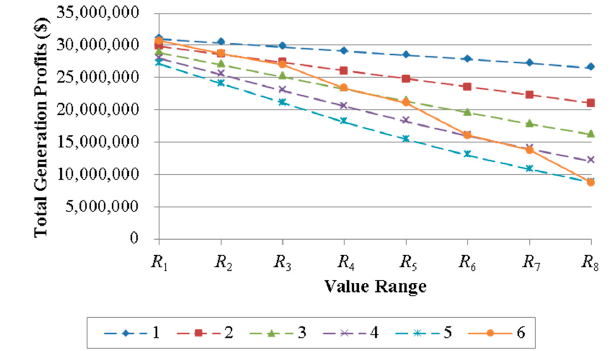
Figure 5. Variations of tax-rate value, emission intensity, and total generation profits with the increase of emission coefficients. Curves 1, 2, 3, 4, and 5 depict the results corresponding to the carbon-tax policy with constant tax rate w 1 , w 2 , w 3 , w 4 , and w 5 , respectively; Curve 6 depicts the results corresponding to the proposed carbon-tax